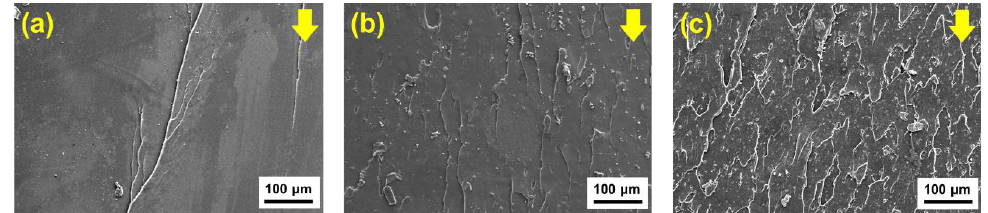
Figure 17. SEM images of the fatigue failure surfaces for the pre-cracked nanocomposites of ( a ) neat epoxy and the ones with MWCNT:GNP ratios of ( b ) 7:3 and ( c ) 1:9; the arrow marks indicate the direction of crack propagation.